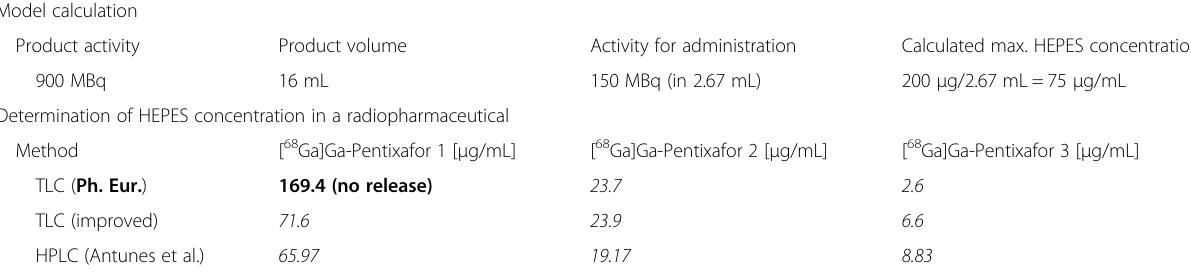
Table 2 Model calculation for maximum allowed HEPES concentration and determination of HEPES content in exemplary [ 68 Ga]Ga-Pentixafor product samples measured with HPLC and TLC